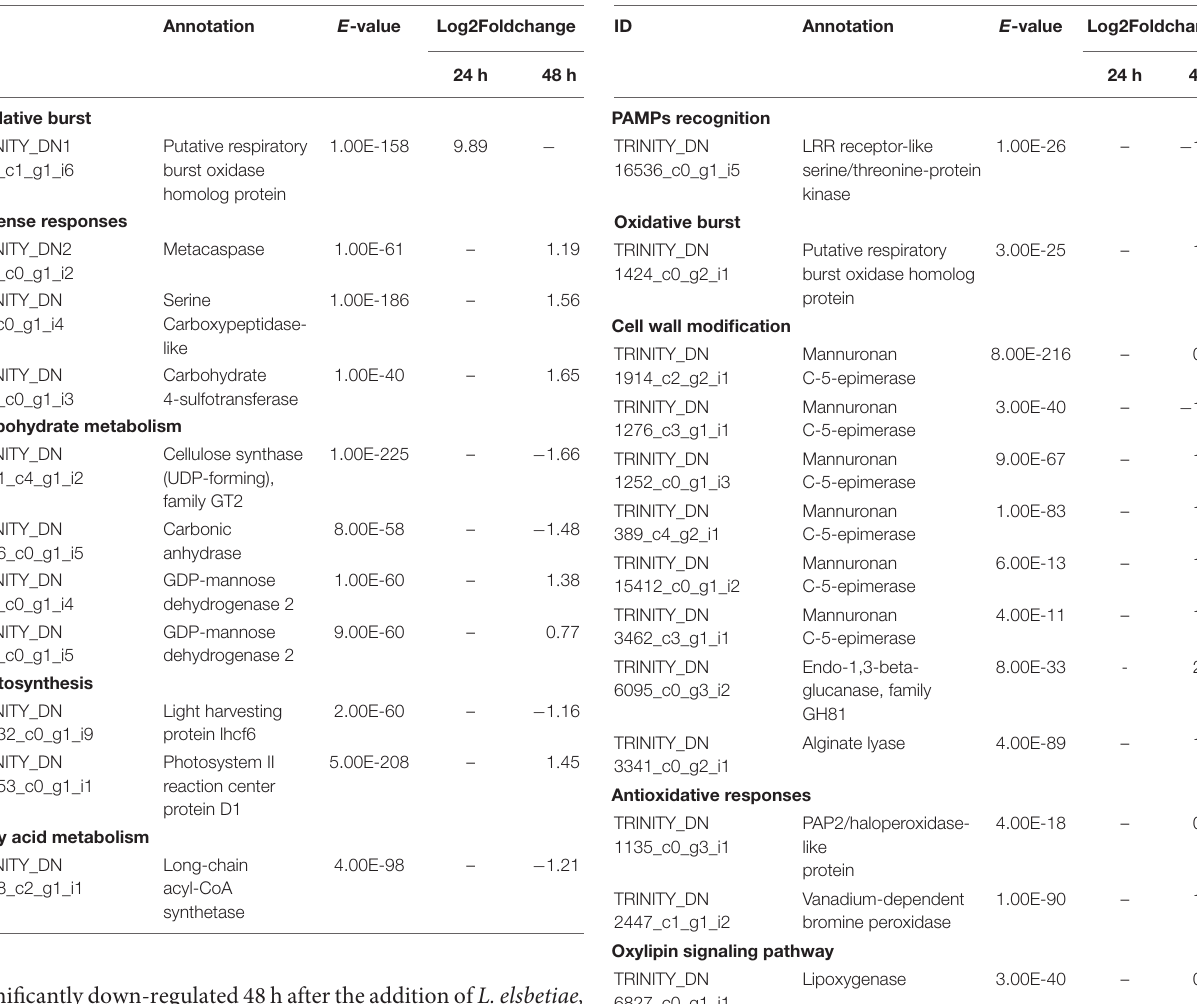
TABLE 3 | Selected significant differentially expressed genes (DEGs) in S. latissima after co-cultivation with L. elsbetiae for 24 and 48 h vs. the control group (q ≤ 0.01, | log2 FC| ≥